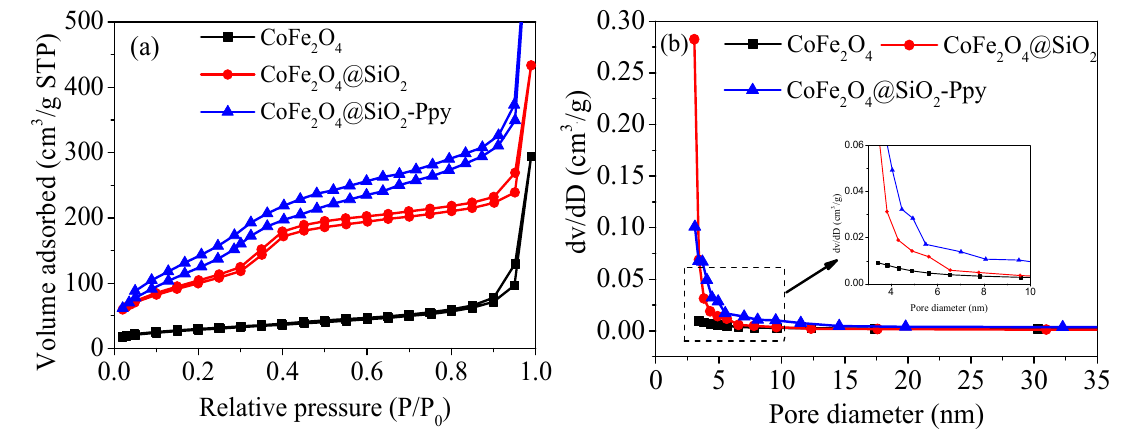
Figure 2. Adsorption-desorption plots ( a ); Size distribution ( b ).